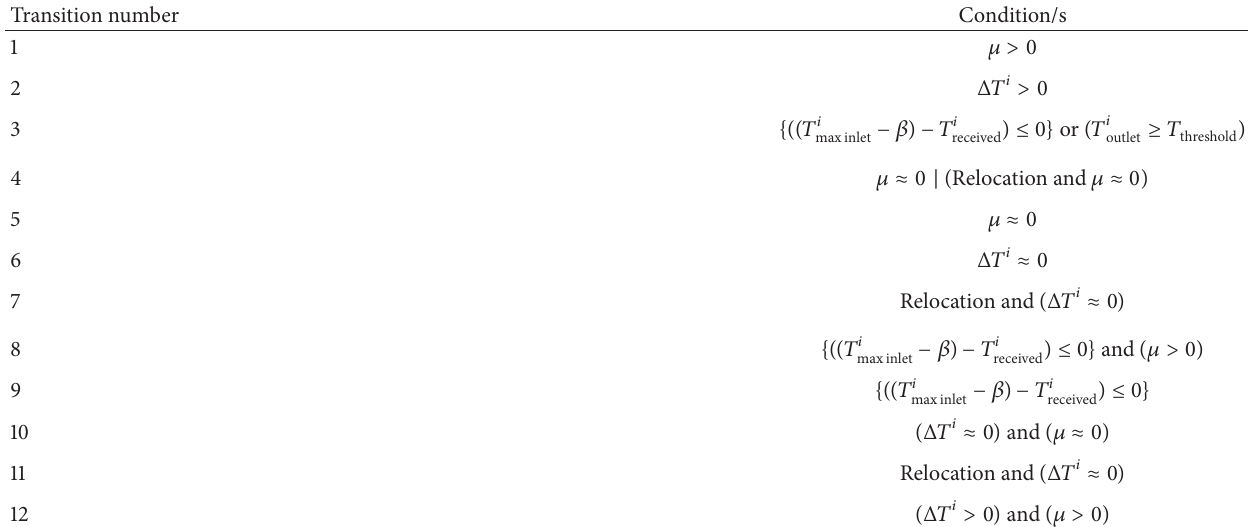
Table 2: Thermal states transition conditions